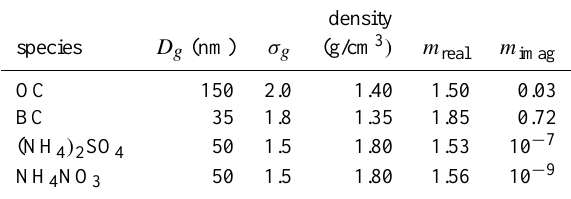
Table 7. Aerosol characteristics used to calculate Mie mass scatter- ing cross section and mass absorption cross section. The geometric mean diameter ( D g ) and geometric standard deviation ( σ g ) describe the lognormal aerosol size distribution. The real and imaginary re- fractive indices ( m real and m imag ) are at a wavelength of